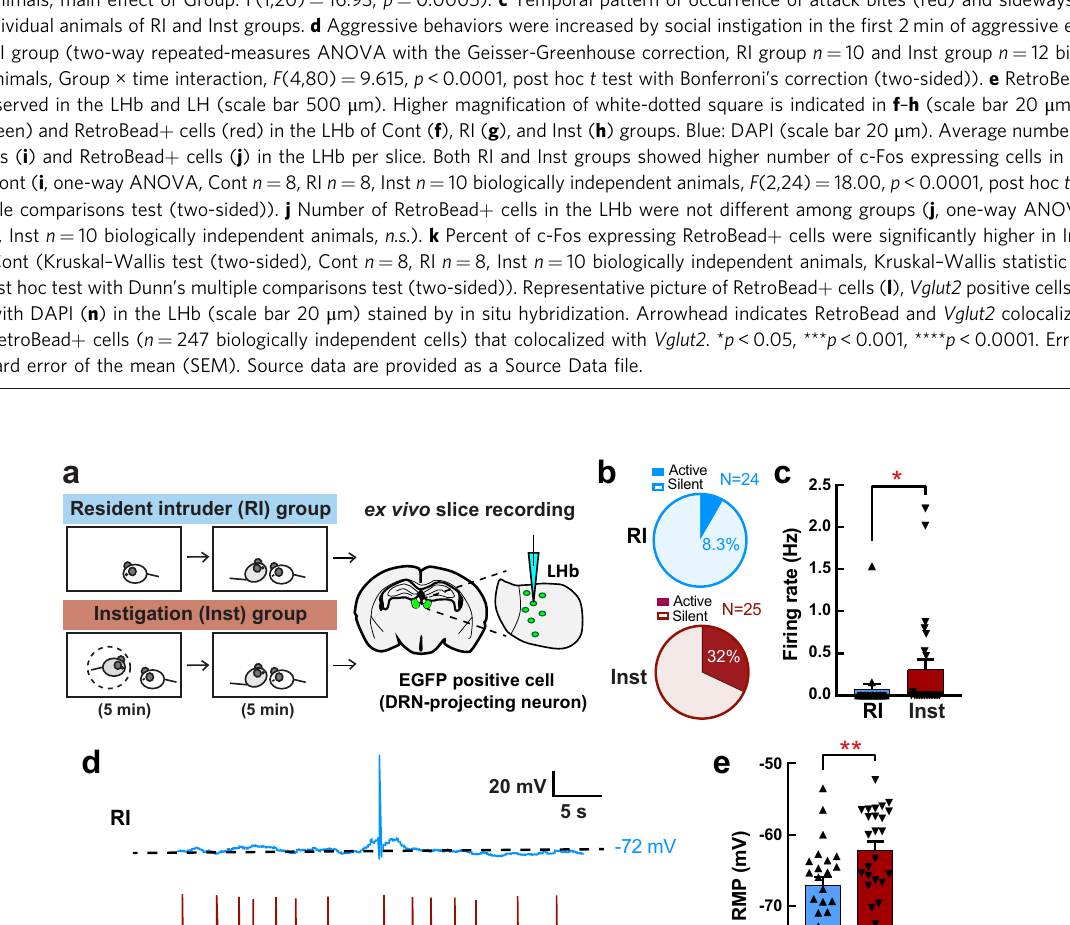
Fig. 2 Social instigation-heightened aggression is associated with increased spontaneous activity in LHb-DRN projection neurons. a Schematics of the experiment. Animals were injected a retrograde AAVretro-hSyn-EGFP into the DRN at least 4 weeks before the test. On the test day, RI group ( n = 5 biologically independent animals) was tested for 5 min RI test, and Inst group ( n = 5 biologically independent animals) had 5 min exposure to a caged- instigator male prior to 5 min aggression test. Recording was conducted from the EGFP + cells in the LHb (3 – 6 neurons per mouse). b Percentage of the recorded neurons that showed spontaneous fi ring (Active) was higher in the Inst group (bottom: 8 Active cells out of 25 recorded cells) than the RI group (top: 2 Active cells out of 24 recorded cells) (Chi-square test, X 2 (1,49) = 4.222, p = 0.0399). c Average fi ring rate was higher in the Inst group compared to RI group (Mann-Whitney test (two-sided), RI n = 25, Inst n = 24 biologically independent cells, U = 228, p = 0.0500). d Representative traces of spontaneous fi ring pattern of the EGFP + LHb neurons of RI animal (top, blue line) and Inst animal (bottom, red line). Black dotted lines indicate the resting membrane potential (RMP) of that cell. e Average RMP (mV) was higher in the Inst group compared to the RI group (Unpaired t test with Welch ’ s correction (two-sided), RI n = 25, Inst n = 24 biologically independent cells, t (46.98) = 2.906, p = 0.0056). * p < 0.05, ** p < 0.01. Error bars indicate standard error of the mean (SEM). Source data are provided as a Source Data fi injection (Fig. 3e). Detailed behavioral analysis showed a similar After the last Inst test, we conducted two additional RI tests effect on the frequency of attack bites (Fig. 3f). Both Inst groups with SAL and CNO injections to examine the effect of LHb-DRN (SAL + Inst and CNO + Inst) showed a higher frequency of attack inhibition on aggression. There was no effect of CNO injection on bites compared to the SAL + RI in the EYFP control group, either aggressive or non-aggressive behaviors in the EYFP control whereas CNO injection reduced attack bite frequency after social or LHb-DRN hM4D groups in the RI test (Fig. 3j – n, Supple- instigation (CNO + Inst) and there was a signi fi cant difference mentary Fig. 3). Therefore, the aggression-suppressive effect of between SAL + Inst and CNO + Inst in the hM4D group (Fig. 3f). LHb-DRN inhibition is restricted to instigation-heightened No group difference was observed in other indices of aggressive aggression. behaviors or non-aggressive behaviors (Fig. 3g – i, Supplementary We also inhibited LHb-DRN neurons optogenetically by Fig. 3). expressing eNpHR3.0 (AAV2-hSyn-eNpHR3.0-EYFP) in the